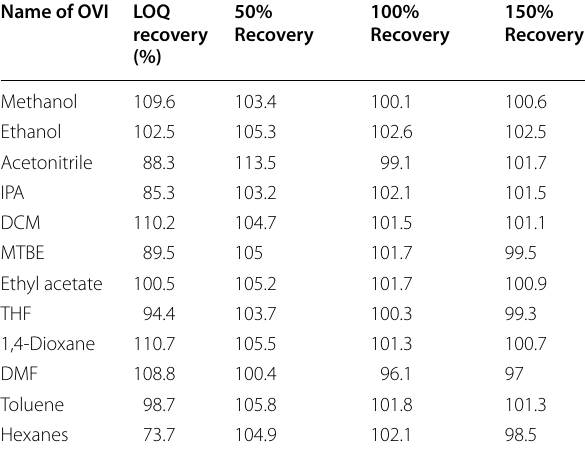
Table 7 System precision data at LOQ